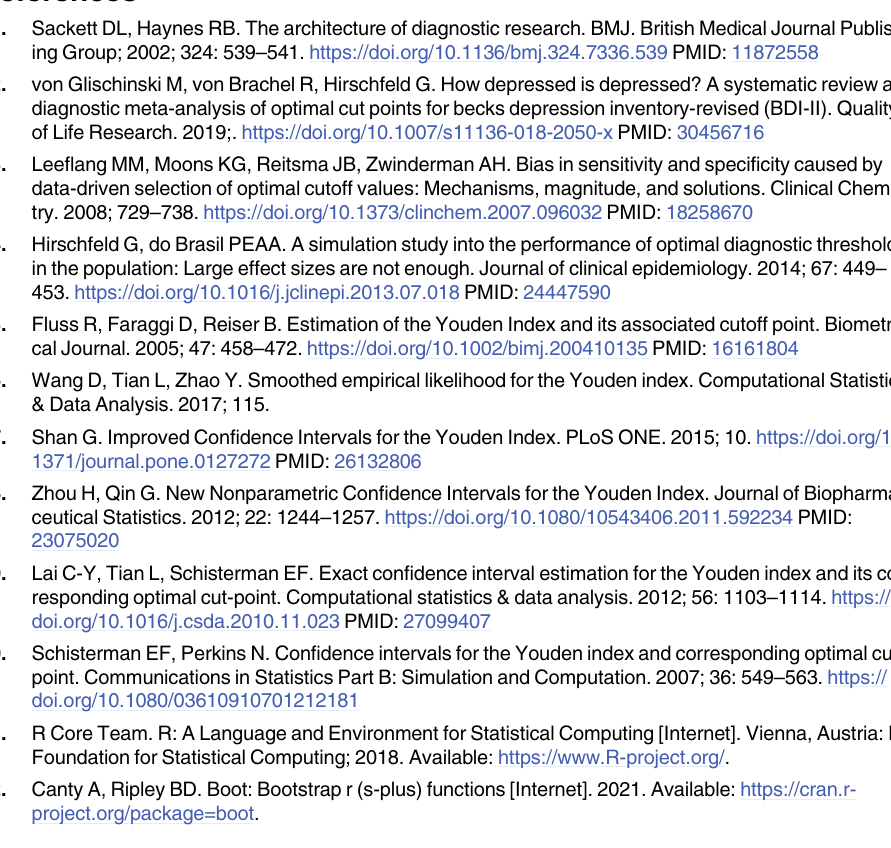
S3 Table. Coverage probabilities of 95% confidence intervals on lognormally distributed data when Youden-Index is J = 0.2. S4 Table. Coverage probabilities of 95% confidence intervals on lognormally distributed data when Youden-Index is J =